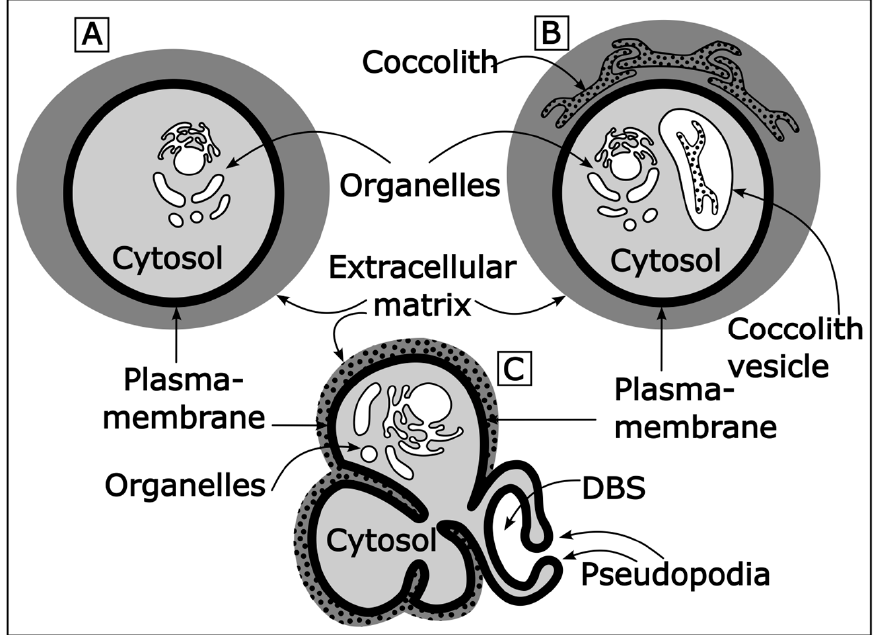
Figure 1. ( A ) Sketch of a cell and its basic compartments. Note that the extracellular matrix is part of the cell. However, the term “intracellular” only refers to parts of the cell that are located inside the plasma membrane. ( B ) Sketch of a coccolithophore cell. The coccolith vesicle is a specialized intracellular compartment producing the coccoliths. The extracellular matrix of coccolithophores is called coccosphere. ( C ) Sketch of a foraminifera cell. The delimited biomineralization space (DBS) is a specialized extracellular compartment that produces the test chambers. The extracellular matrix of foraminifera is called test (or shell). It should be noted that extracellular and intracellular calcification both occur within the cell, but intracellular calcification takes place in a compartment inside the plasma membrane and extracellular calcification takes place in a compartment outside the plasma